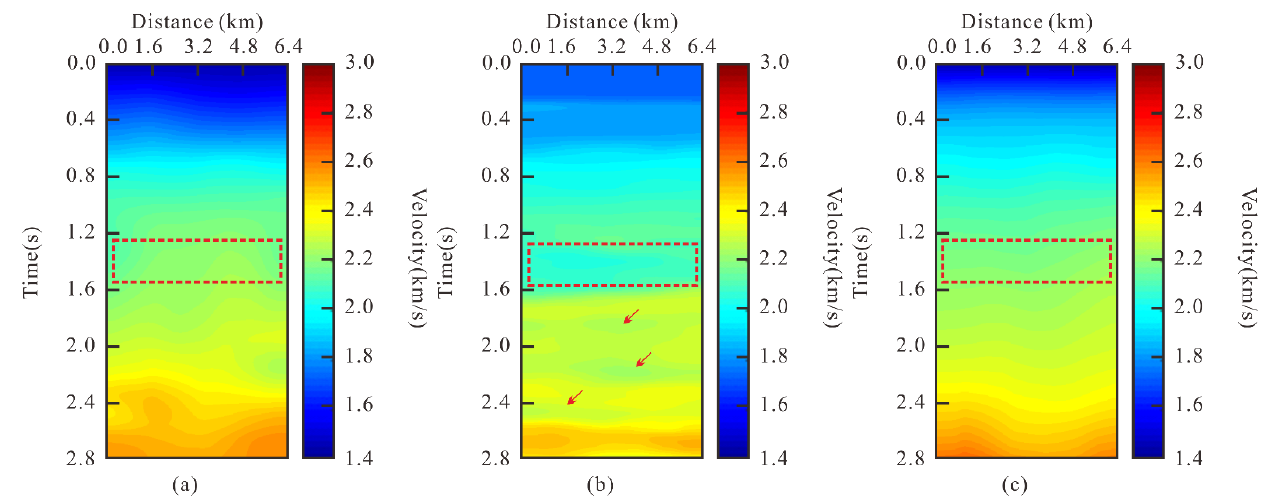
Figure 9. Comparison of velocity model: ( a ) reference model, ( b ) velocity model obtained by control group, ( c ) velocity model obtained by proposed method.